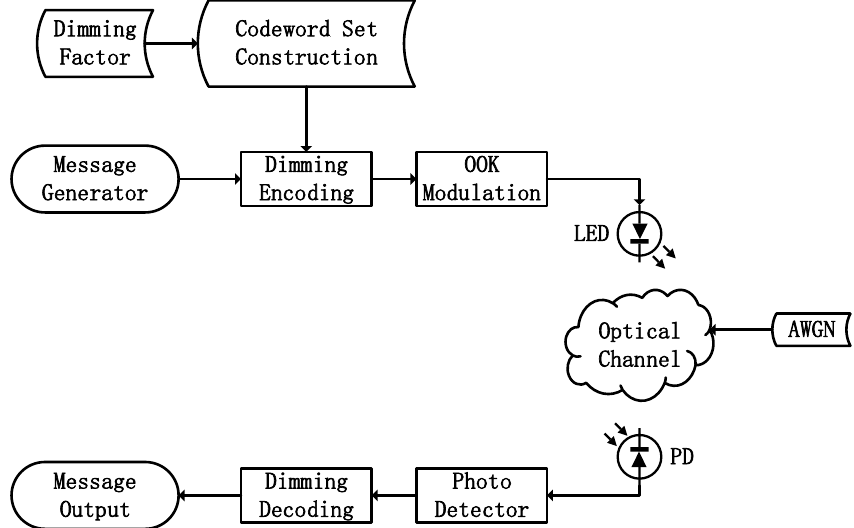
Figure 1. System model of the proposed dimming control scheme applied to on-off keying (OOK)